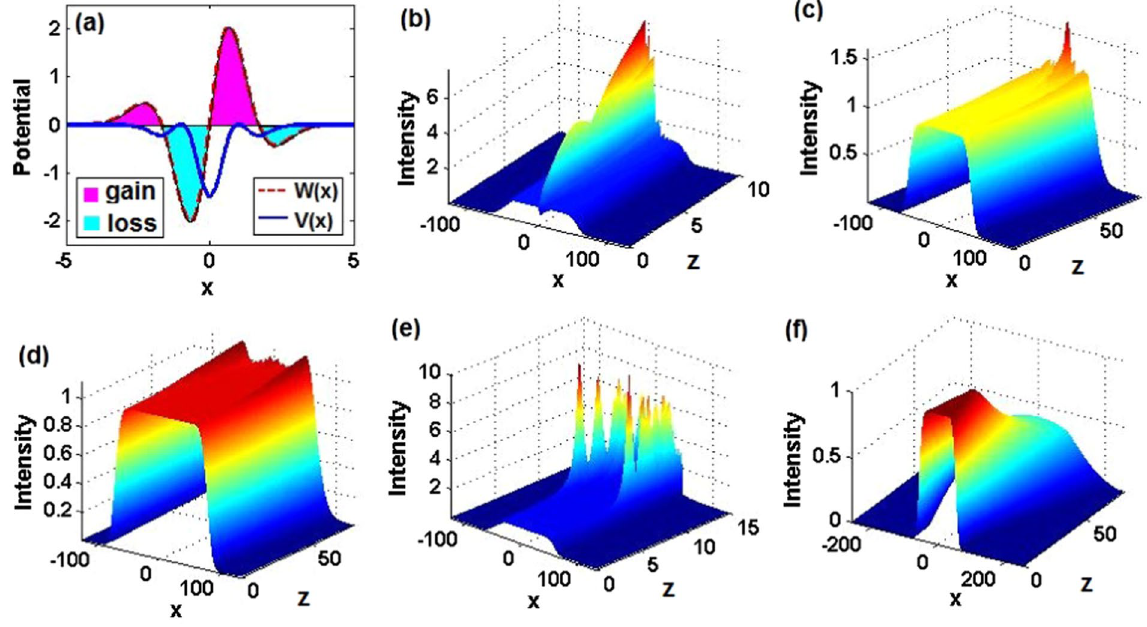
Figure 6. Constant-intensity waves in linear and nonlinear PT -symmetric systems with the complex potential of Hermite-Gauss (HG) type. ( a ) Real (solid blue) and imaginary (dashed red) parts of the complex potential + V x iW x ( ) ( ) given by Eq. (9) hereafter, magenta- and cyan-filled areas designate the presence of the gain and loss, respectively. ( b ) The evolution of the constant-amplitude wave without the correctly introduced initial phase at z = 0 in the linear setting ( g = 0). Spatial diffraction of ( c ) narrow and ( d ) wide truncated constant- intensity waves. The evolution of the constant-amplitude wave with the correct phase at z = 0 under ( e ) the self-